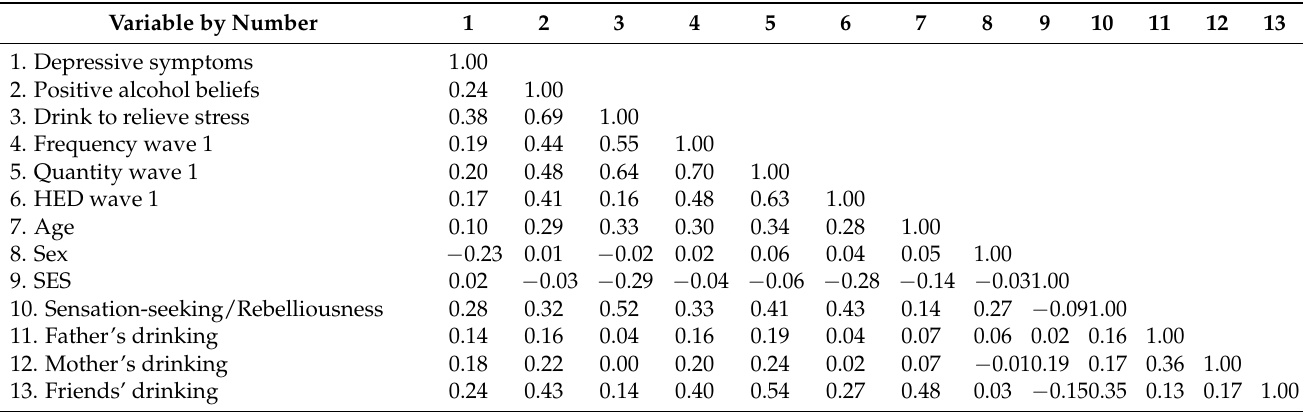
Table 2. Zero-order correlations a of key variables.